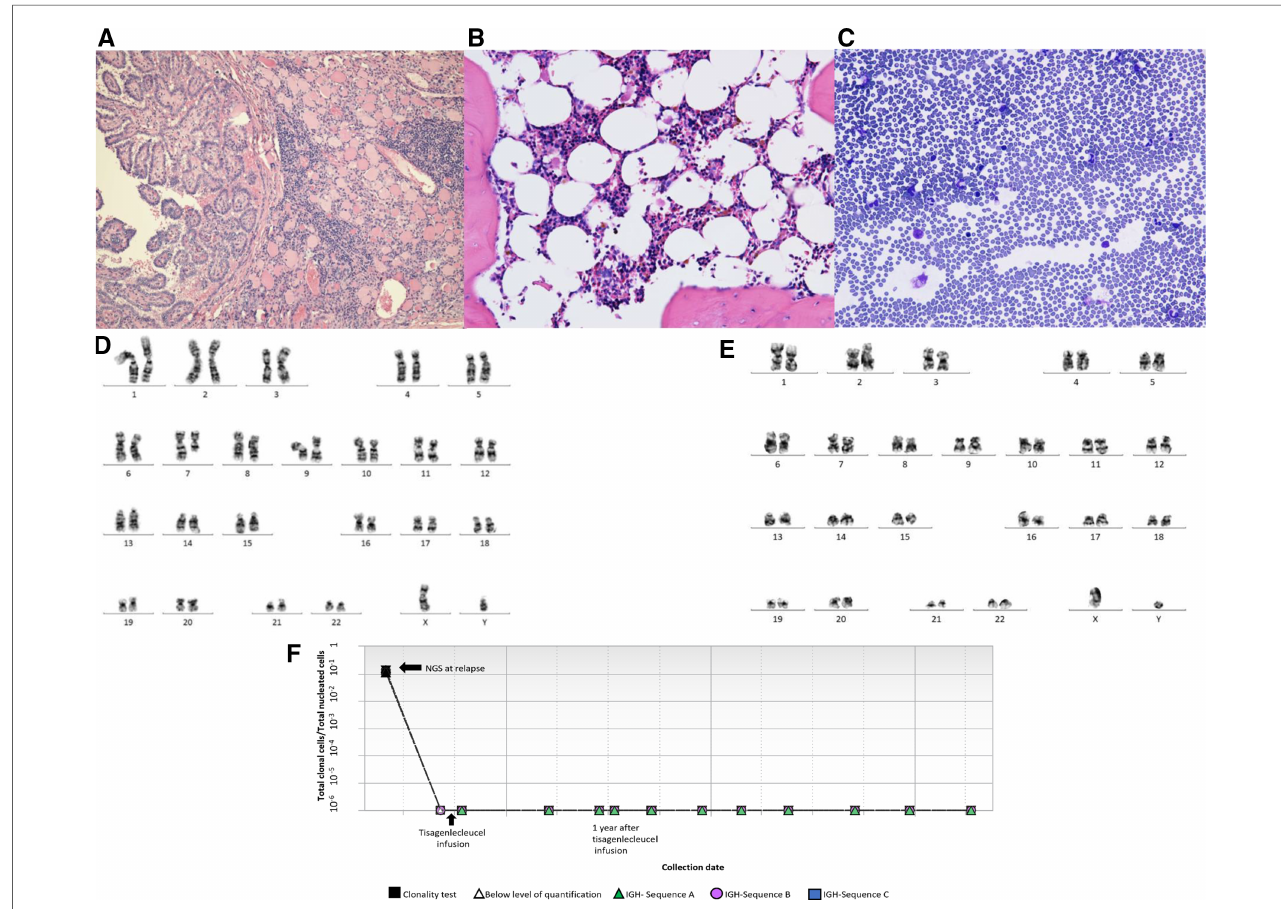
FIGURE 2 ( A ) Thyroidectomy reveals thyroid tissue with focal chronic in fl ammation and a papillary carcinoma (H&E stain, 100×). ( B ) Representative bone marrow biopsy reveals hypocellular marrow with trilineage hematopoiesis and no overt dysplasia (H&E stain, 400×). ( C ) Representative bone marrow aspirate reveals few erythroid and granulocytic cells with no overt dysplasia (Giemsa stain, 400×). ( D ) Karyotyping showing deletion of 7q. ( E ) Karyotyping showing absence of deletion 7q in most recent bone marrow specimen. ( F Next generation sequencing (NGS) showing detection of leukemic clones at relapse and remission (0 residual clonal cells) at 1, 2 and 3 years after receiving